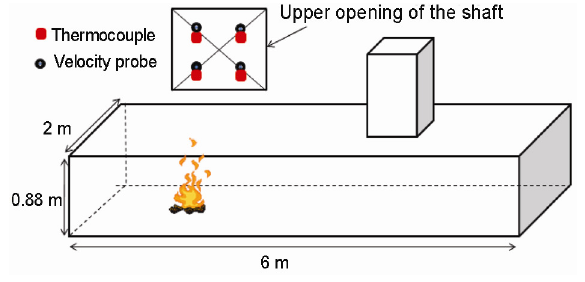
Fig. 1. Schematic of experimental apparatus